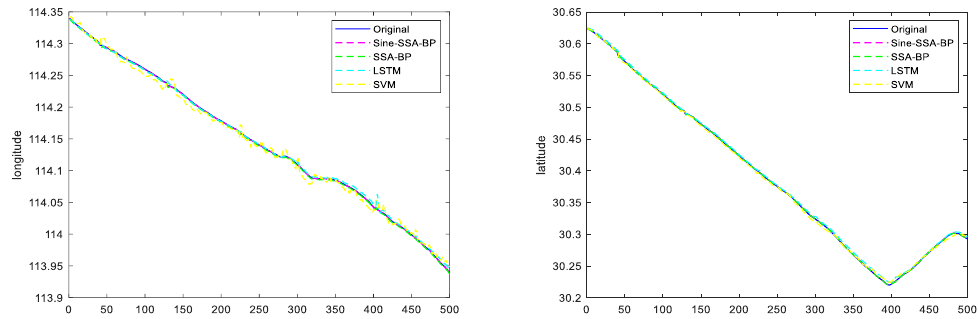
Figure 12. Plots of predicted longitude and latitude for different model trajectories in Scenario Figure 12 . Plots of predicted longitude and latitude for different model trajectories in Scenario 1. Figure 12 . Plots of predicted longitude and latitude for different model trajectories in Scenario 1. Figure 12 . Plots of predicted longitude and latitude for different model trajectories in Scenario 1.